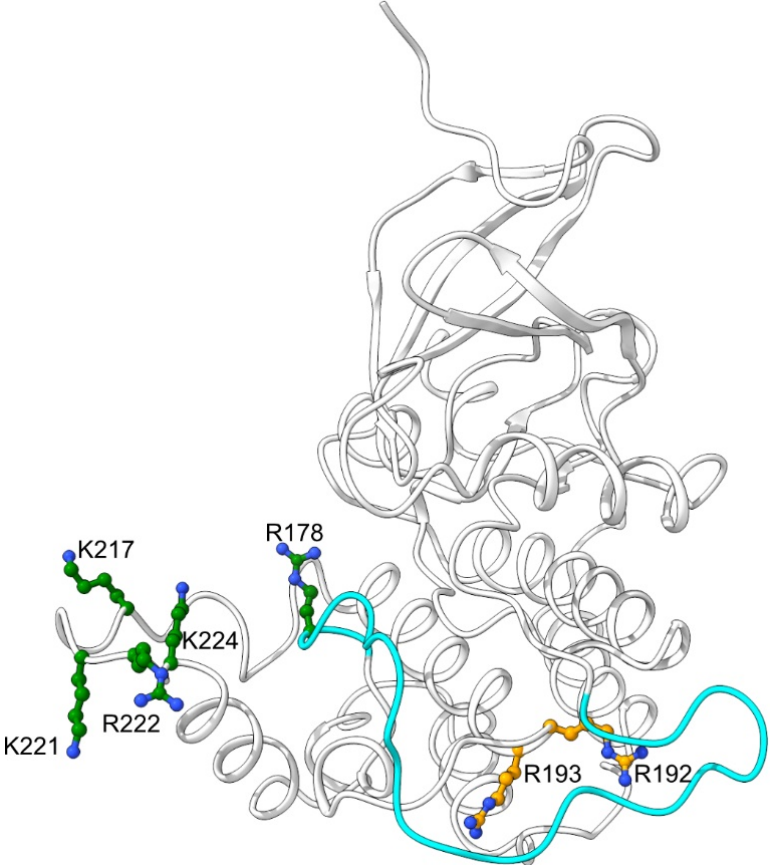
Figure 1. The positions of the amino acids changed in the boxed region of Scheme 1 are indicated in the structure of rat casein kinase Iδ truncated at amino acid 317 (PDB ID 1 CKJ) [30]. Mutations that shortened period are indicated in green, including the tau mutation (R178) and the NLS mutations (K221, R222, and K224). Amino acid changes that lengthened period (R192 and R193) are colored orange. The aliphatic portions of these amino acids are buried and located below the activation loop (colored cyan on the figure). Mutations of these amino acid residues to asparagine presumably alter the position of the activation loop, leading to an increase in period. This figure was prepared using Chimera X [31].